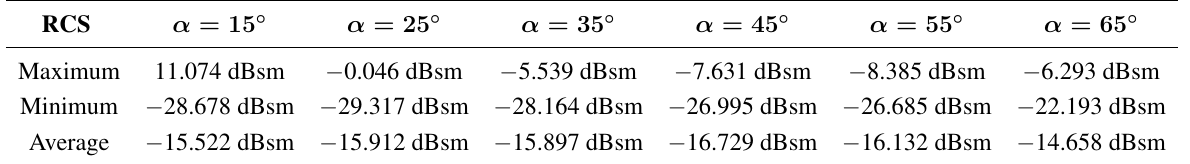
Table 4. Simulated bistatic RCS for the car model used for calculating the received power in Figure